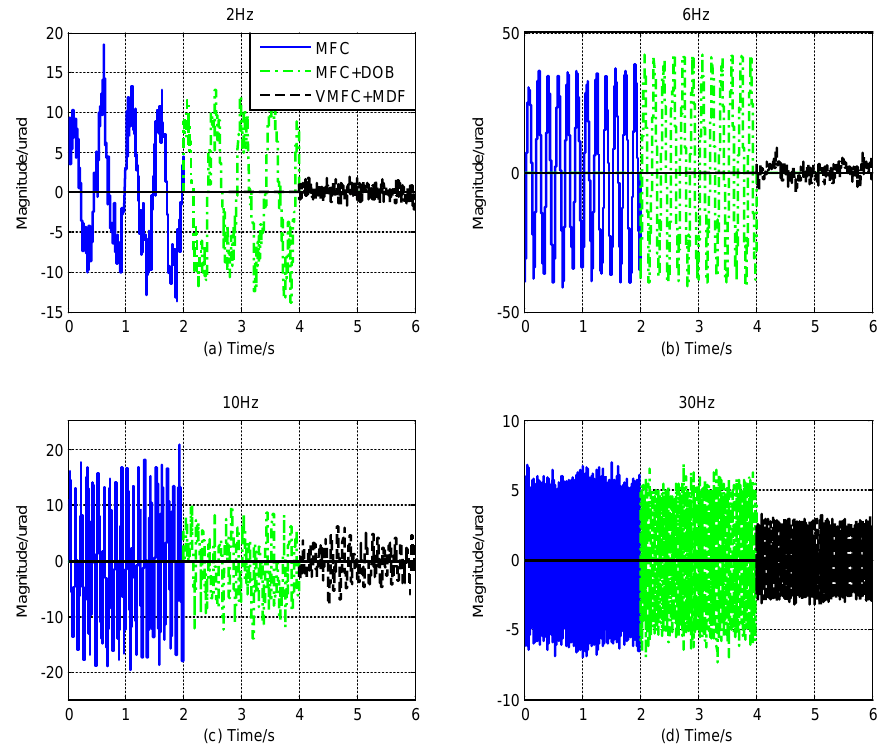
Figure 13. Comparison of disturbance suppression effect between the MFC with disturbance observer (DOB) and the VMFC with MDF in time domain. Table 1. Root mean squares (RMS) of three control methods.